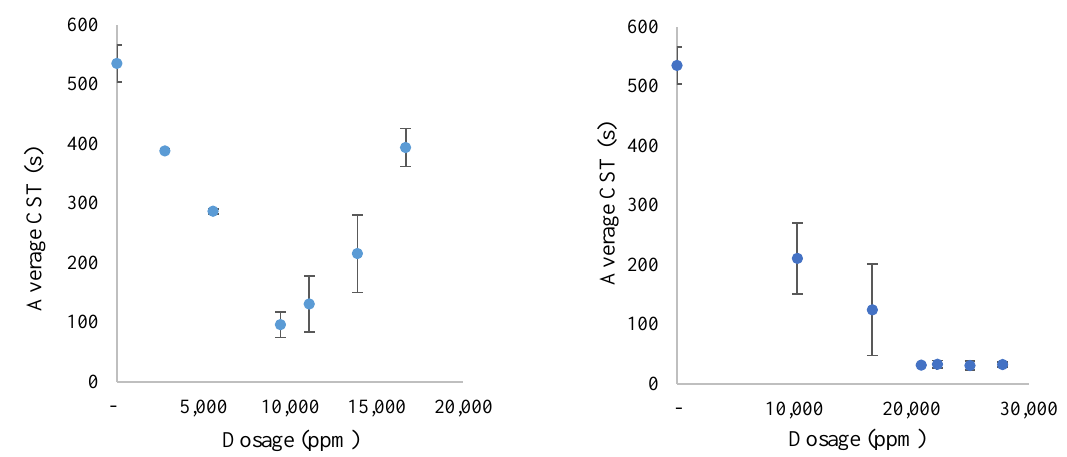
Figure 5. Capillary suction time measurement of MFT flocs after treatments with poly(TMAEMC) ( left ) and poly(PLA 4 ChMA) ( right ) at varying dosages. CST: capillary suction time.